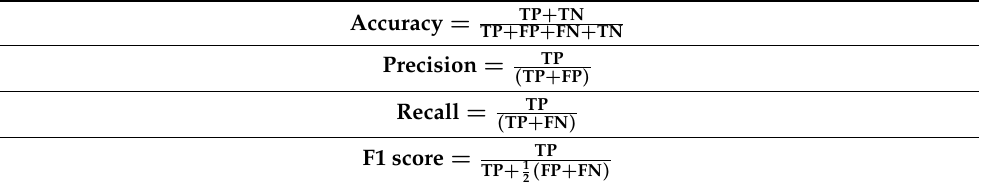
Table 5. Evaluation metrics.